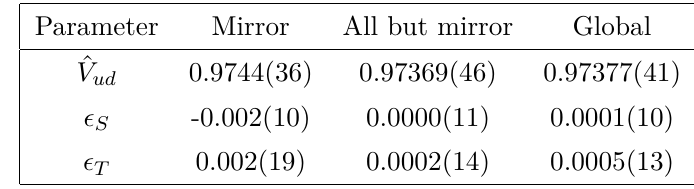
Table 5 . Comparison of the sensitivity of mirror and other data sets to the parameters of the quark-level Lagrangian in eq. (2.1), in the scenario where all ˜ (cid:15)